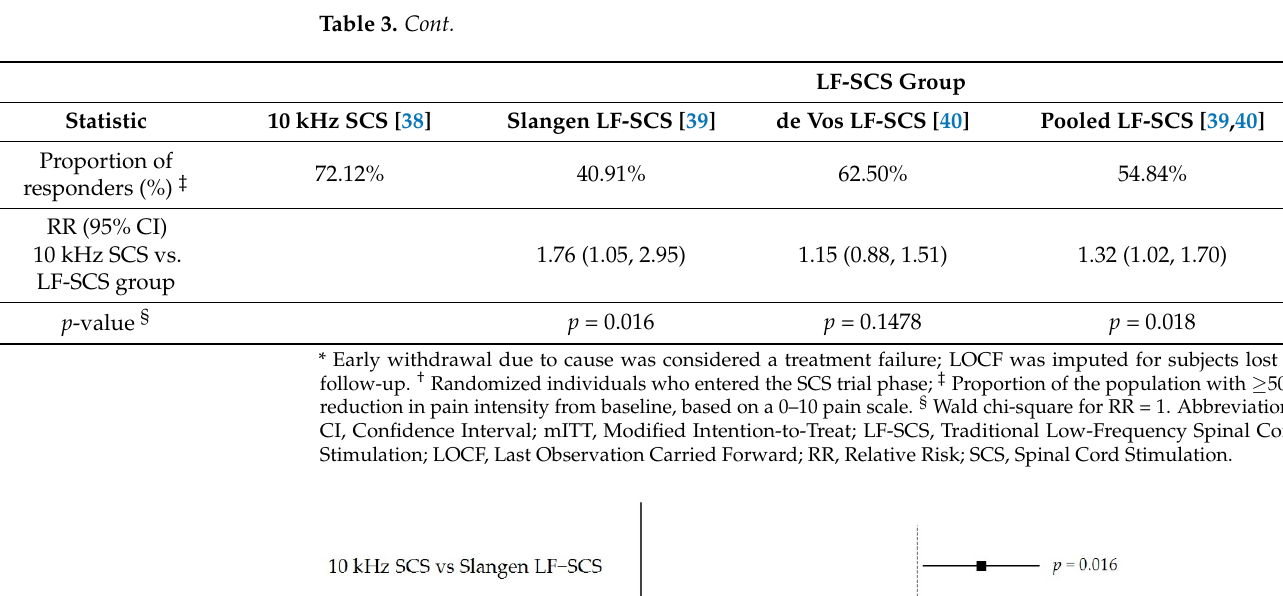
Table 3. Comparison of the mITT population responder rates at 6 months.